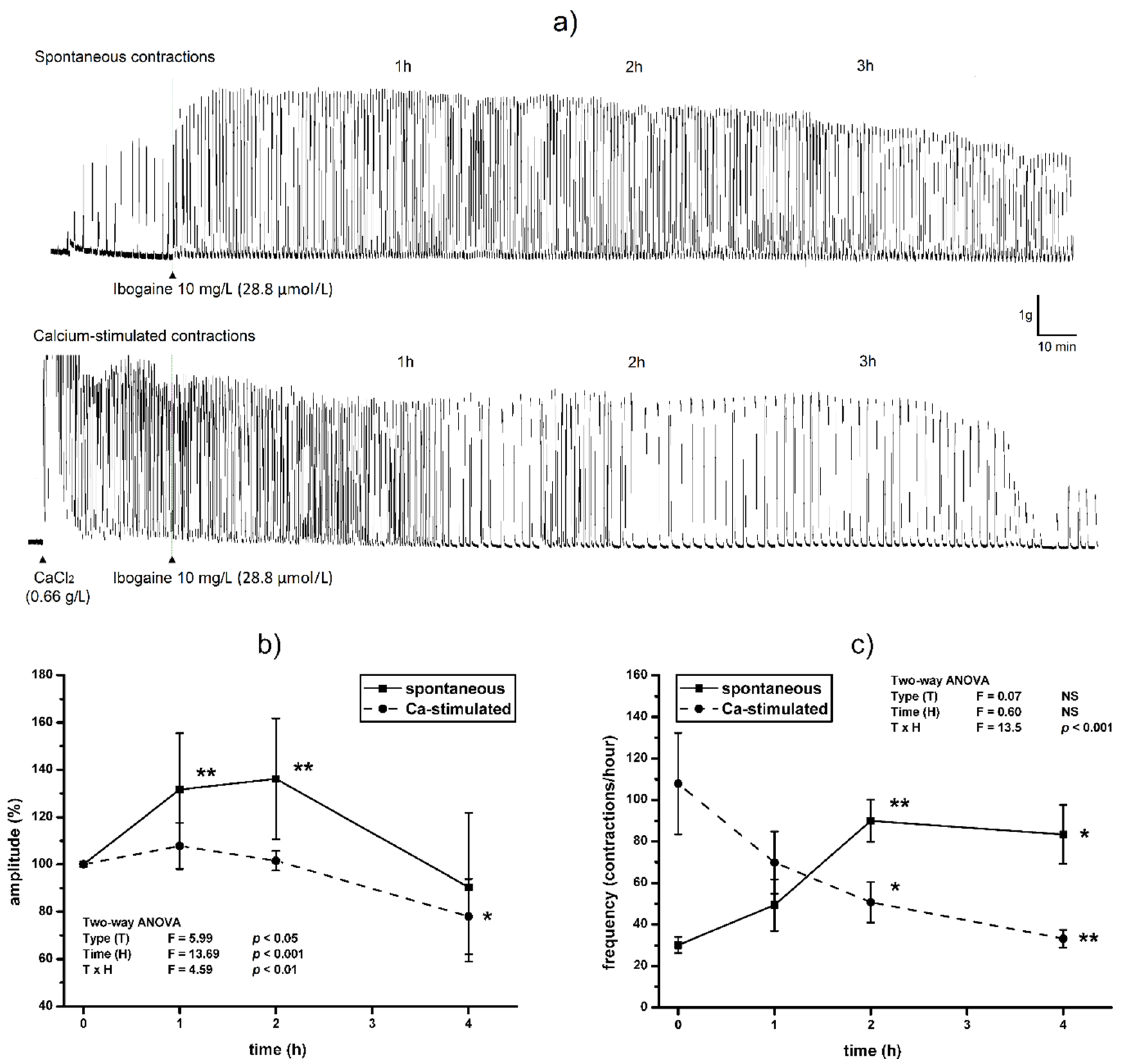
Figure 1. The effect of single dose of ibogaine (28.8 μ mol/L) on uterine contractility: ( a ) Representative original traces of spontaneous and Ca 2+ -stimulated active uterus during 4 h, treated with a single dose of ibogaine. ( b ) Uterine amplitude levels during 4 h after a single dose of ibogaine treatment. ( c ) Uterine frequency levels during 4 h after a single dose of ibogaine treatment. Results are expressed as the mean ± SEM ( n = 7). Statistical significance was tested by two-way ANOVA (factors (F): type of contraction—T and time—H) and post hoc compared by Tukey’s HSD test. * p < 0.05; ** p < 0.01; NS—non-significant.